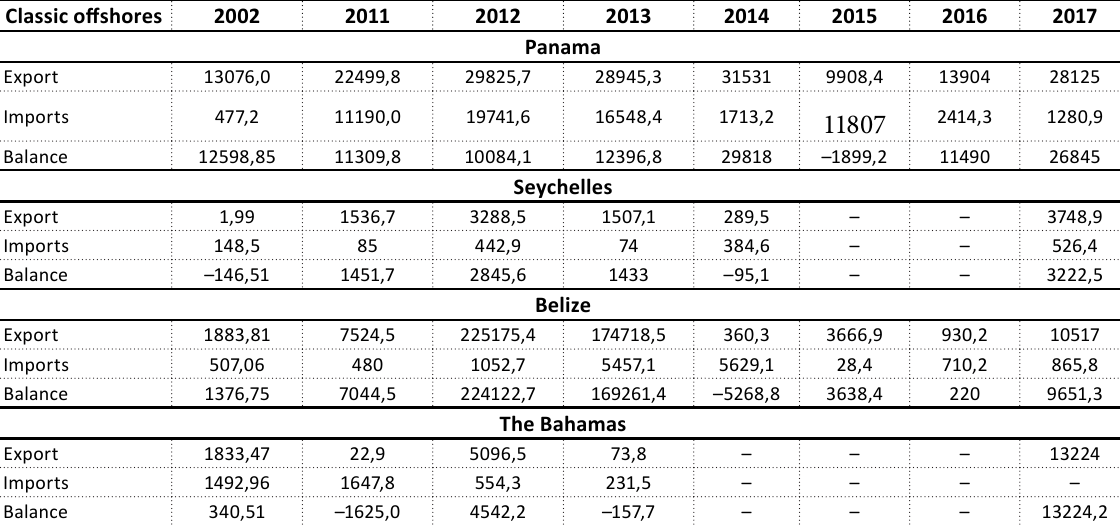
Source: Data from the State Statistics Committee of Ukraine, World